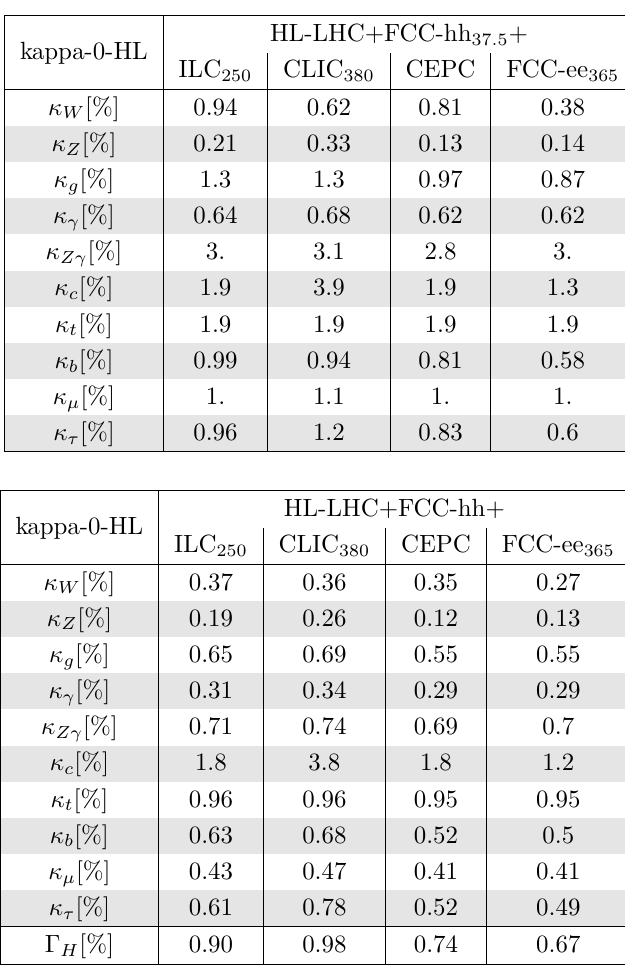
Table 36 . Expected relative precision (%) of the (cid:20) parameters in the kappa-0-HL scenario described in section 2 for future lepton colliders combined with the HL-LHC and the FCC-hh 37 : 5 (top part) and with HL-LHC and FCC-hh (bottom part). No BSM width is allowed in the (cid:12)t: both BR unt and BR inv are set to